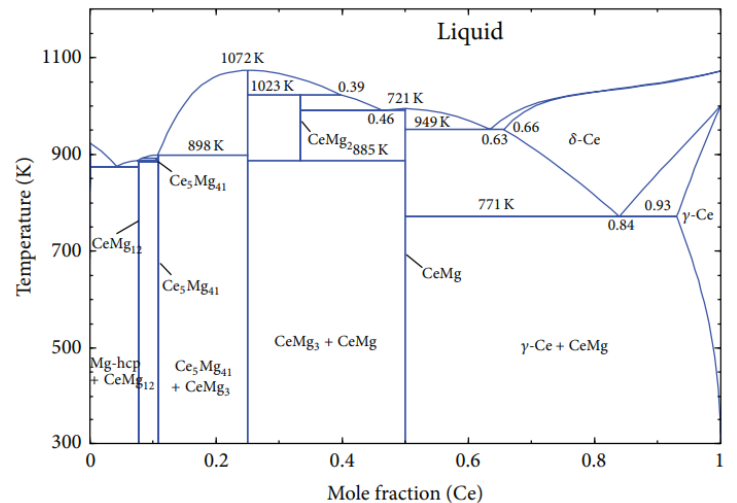
Figure 5. Mg-Ce phase diagram [77].